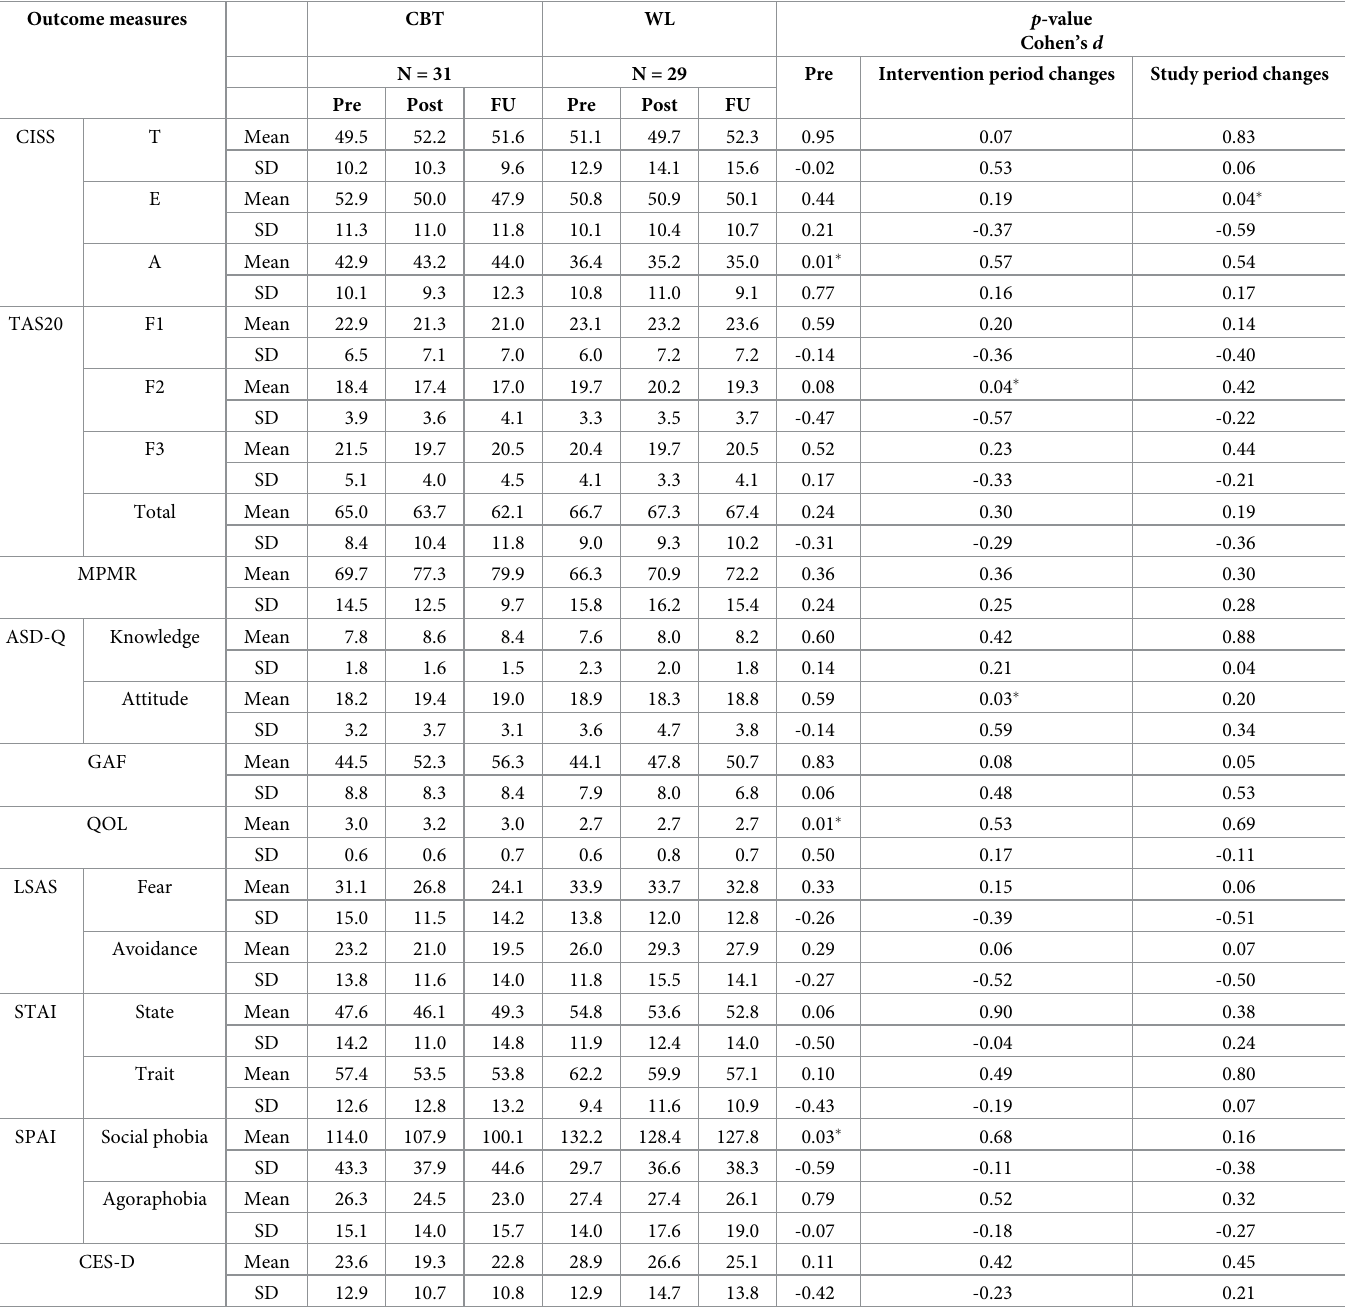
Table 3. Comparisons of outcome measures for CBT and waitlist groups at pre-intervention (pre), post-intervention (post), and follow-up (FU). Outcome